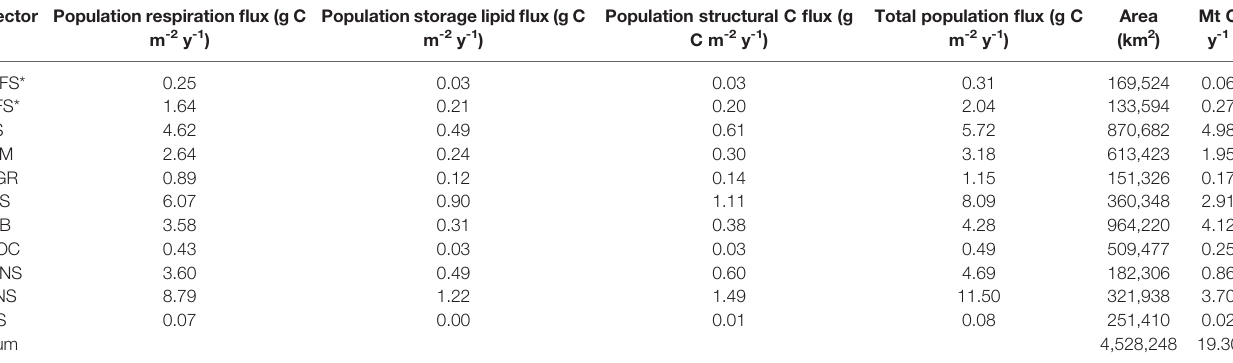
TABLE 7 | Calanus fi nmarchicus : Spatially-discrete (g C m -2 y -1 ) and spatially integrated (Mt C y -1 ) population C fl ux for the West Fram Strait (WFS), East Fram Strait (EFS) and different ocean sectors as calculated by Jo ́ nasdo ́ ttir et al. (2019). Sector Population respiration fl ux (g C m -2 y -1